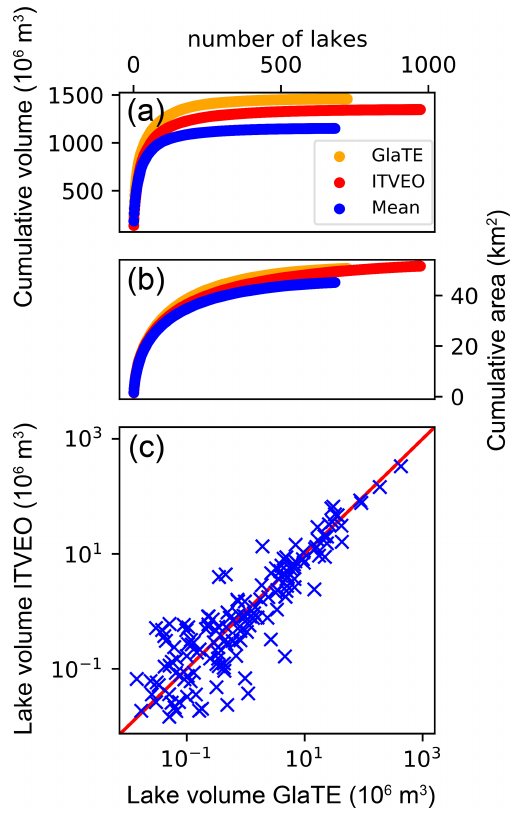
Figure 6. Cumulative (a) volume and (b) area of all potential lakes detected with GlaTE (orange), ITVEO (red), and the mean bedrock topography (blue). (c) Comparison of the volume of potential lakes per glacier detected with GlaTE and ITVEO. The volume calculated with the two models is equal along the red line. Note the logarithmic